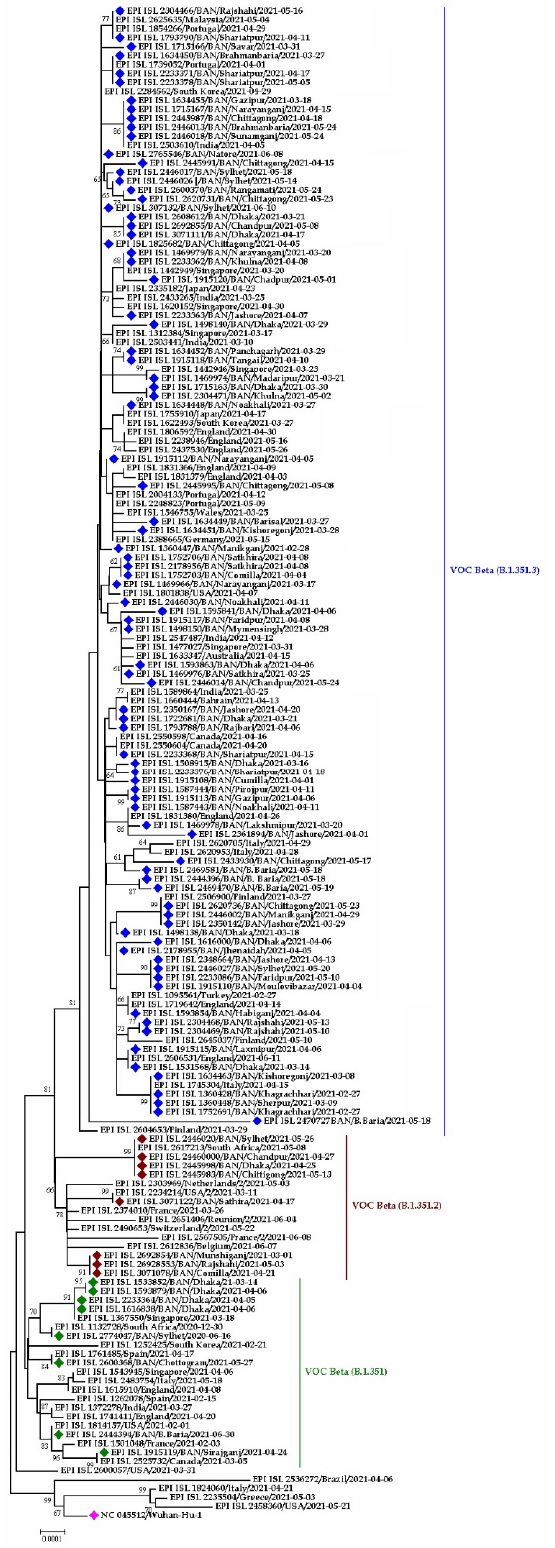
Figure 9. Phylogenetic analysis of sub-lineage Beta variant B.1.351.3 in Bangladesh. Here, blue dots denote Beta (B.1.351.1) SARS-CoV-2 viruses, and maroon, green and pink dotes denote B.1.351.2, B.1.351, and Wuhan-Hu-1 viruses, respectively.